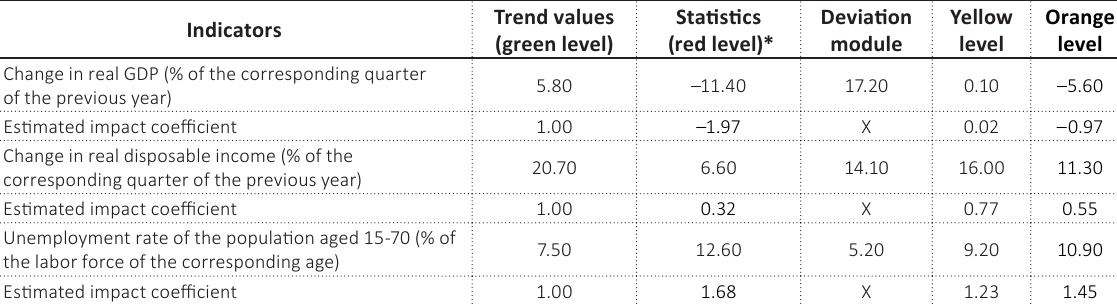
Table 4. Modeling intermediate impact coefficients based on the results of comparing trend and statistically significant values of individual macro indicators in the second quarter of